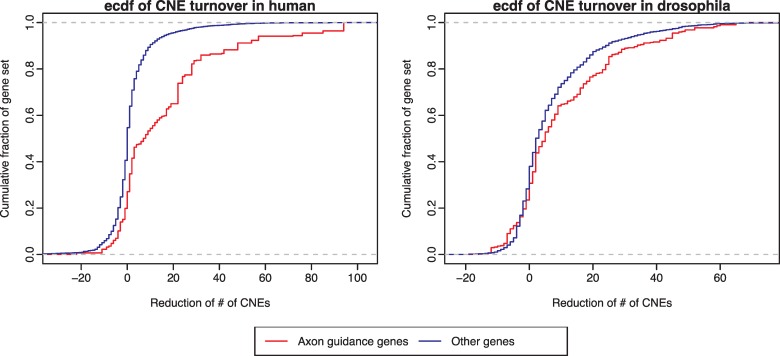
Cumulative distribution function of the changes of CNE number.For a 40kb window around each orthologous gene pair between human and Drosophila, we calculate the reduction of the number of CNEs for human (# of CNEs from human-mouse comparison minus # of CNEs from human-zebrafish comparison) and Drosophila (# of CNEs from D. melanogaster vs. D. ananassae comparison minus # of CNEs from D. melanogaster vs. Glossina) as reference. The axon guidance genes significantly show a higher degree of CNE number reduction, compared with the other genes (p < 1e-5, Kolmogorov-Smirnov one-sided test).